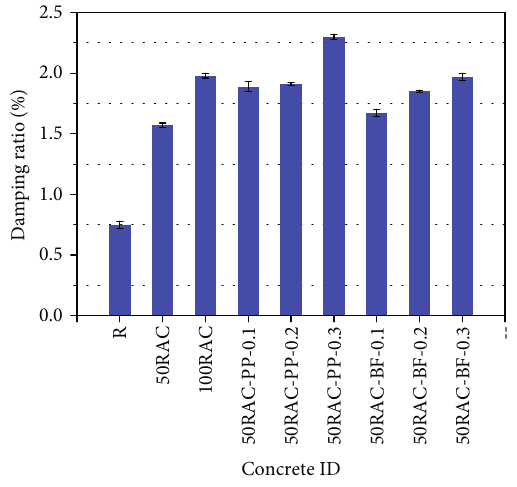
Figure 10: Damping ratio of